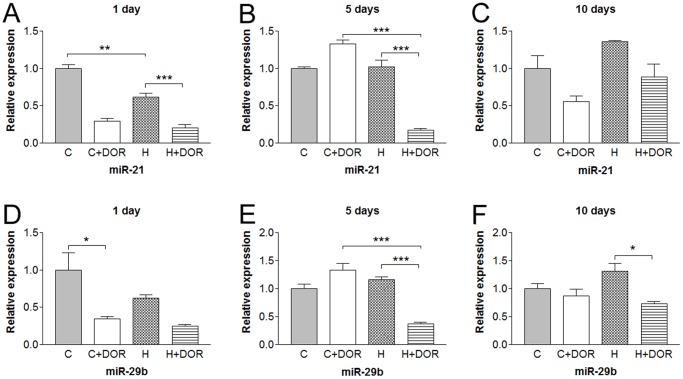
Relative miRNA expression levels of miR-21 and miR-29b in the kidney following either 1, 5, or 10 days of hypoxia as determined by quantitative RT-PCR.C, control; C+DOR, control+UFP-512; H, hypoxia; H+DOR, hypoxia+UFP-512. *p<0.05, **p<0.01, ***p<0.001.